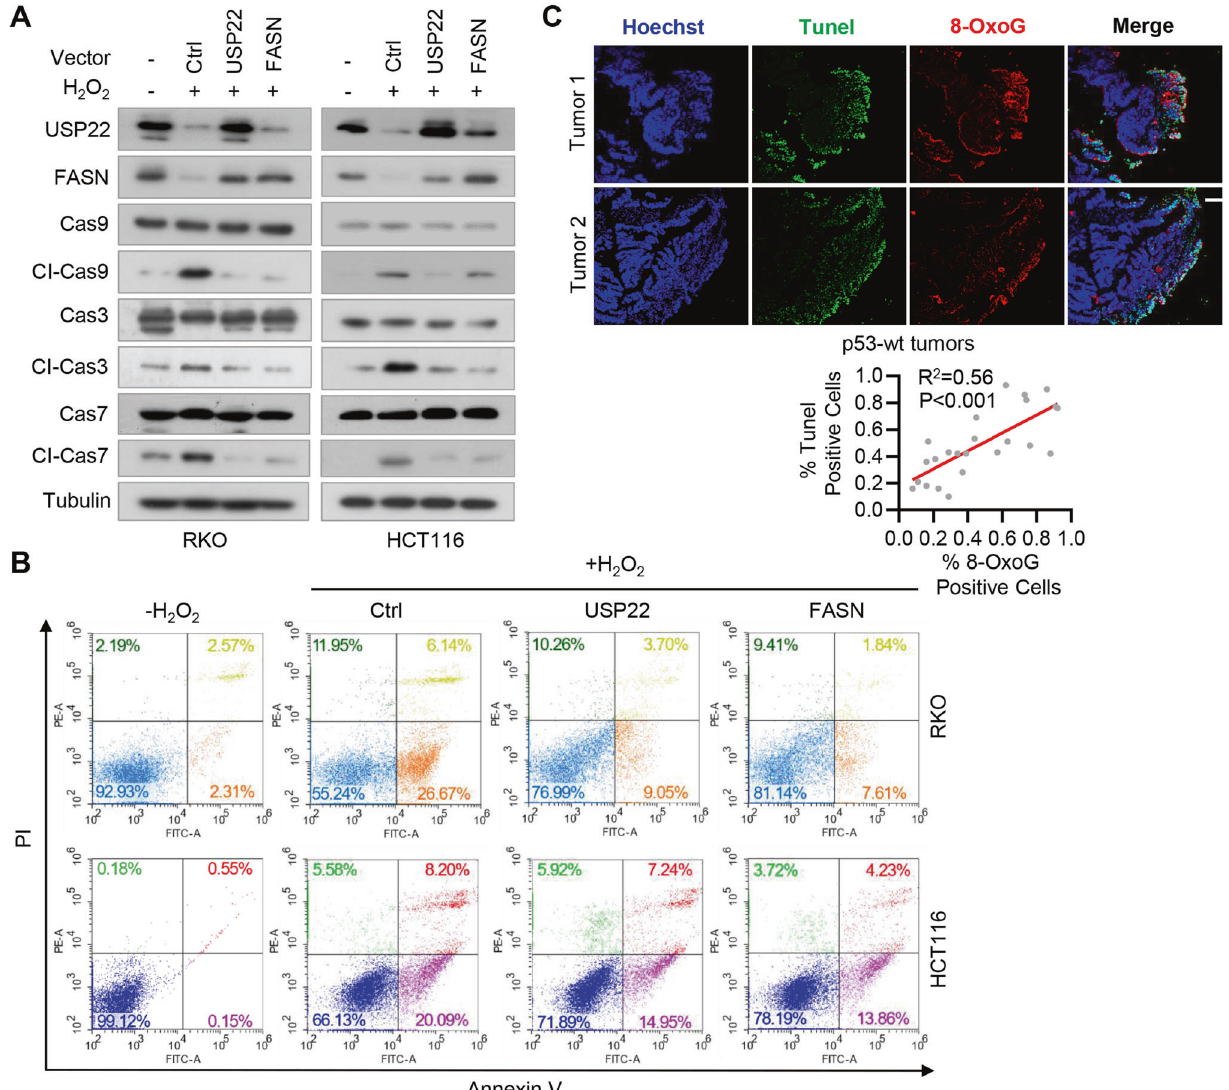
B RKO and HCT116 cells expressing USP22 or FASN were treated with H 2 O 2 , and then double stained with Annexin V/propidium iodide (PI). Cell apoptosis was analyzed by fl ow cytometry. C CRC tissues with wild-type p53 were labeled by Tunel (Green) and anti-8-Oxoguanine antibody (Red), and images were taken using a Zeiss confocal microscope. Representative images of two tumors are shown. Scale bar, 200 μ m. The percentages of 8-OxoG and Tunel positive cells in each microscope fi eld were analyzed and compared (4 randomly selected fi elds for each tissue, 6 tissues, Pearson correlation